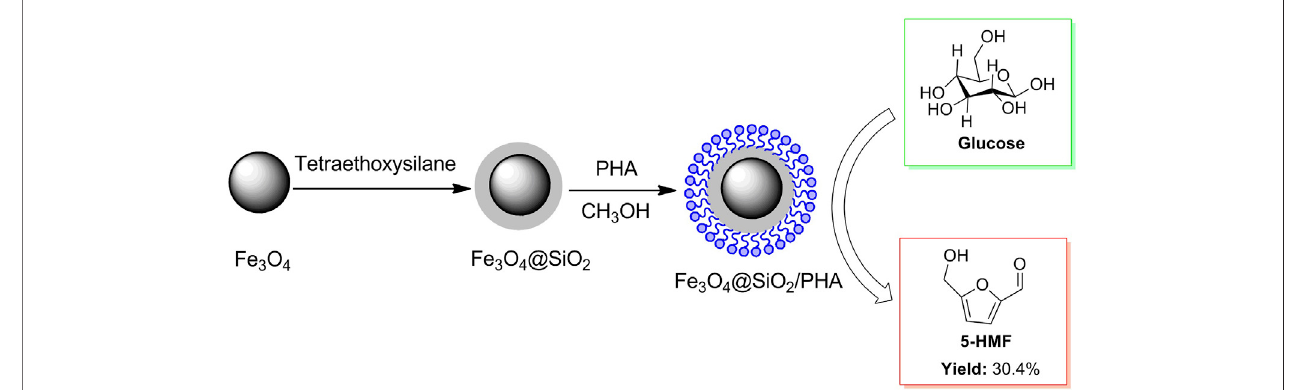
FIGURE 10 | Synthesis and application of Fe 3 O 4 @SiO 2 /PHA in glucose conversion.